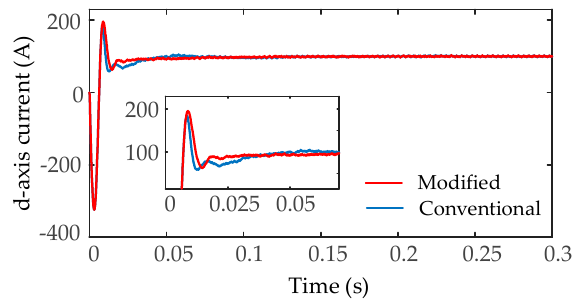
Figure 13. Comparison of d-axis current tracking performance under stationary operating conditions ( irradiance S = 1000 W/m 2 , module temperature T = 25 ◦ C ) .